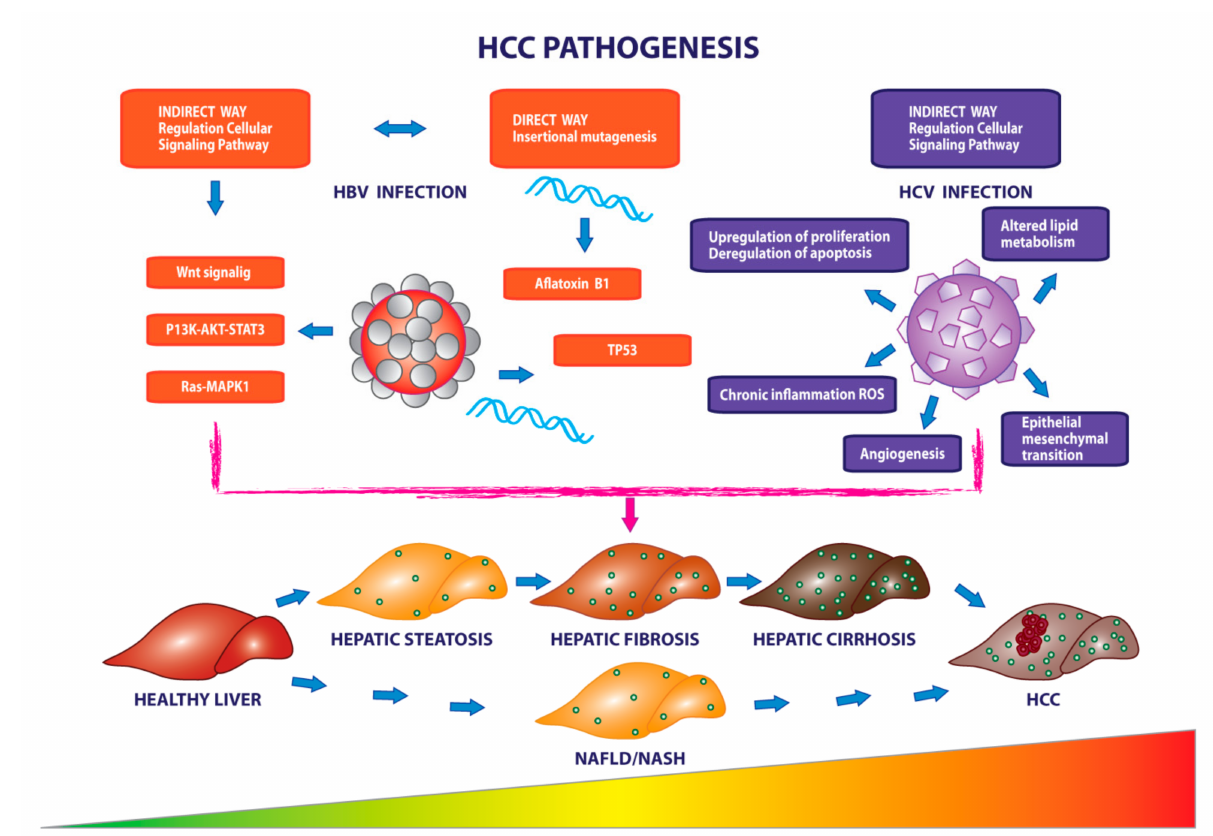
Figure 1. Involvement of viral infections in the pathogenesis and progression of HCC. The pathogenesis of HCC is closely related to the presence of viral infections from hepatitis B and hepatitis C. Viral agents support the onset and progression of cancer through consequential events involving genetic alterations, increased reactive oxygen species and angiogenesis occurring during tumor progression from healthy liver to diseased